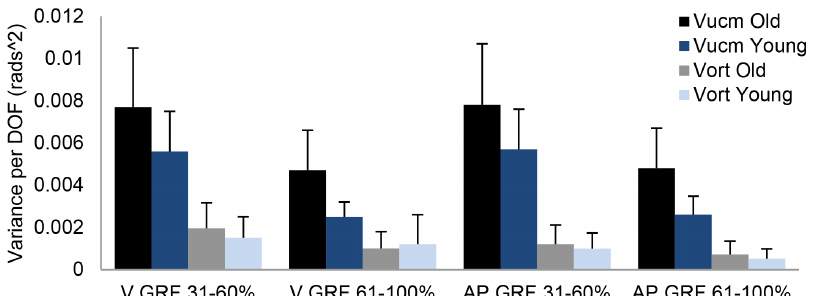
Figure 3. V UCM and V ORT for GRF in old and young participants. Variance per degree of freedom for old and young participants in the vertical and anterior-posterior dimension of the GRF during lift-off (31–60%) and extension phase (61–100%) of the sit-to-stand task. DOF: degrees of freedom. V: vertical. AP: anterior-posterior. Error bars represent standard error of the mean.